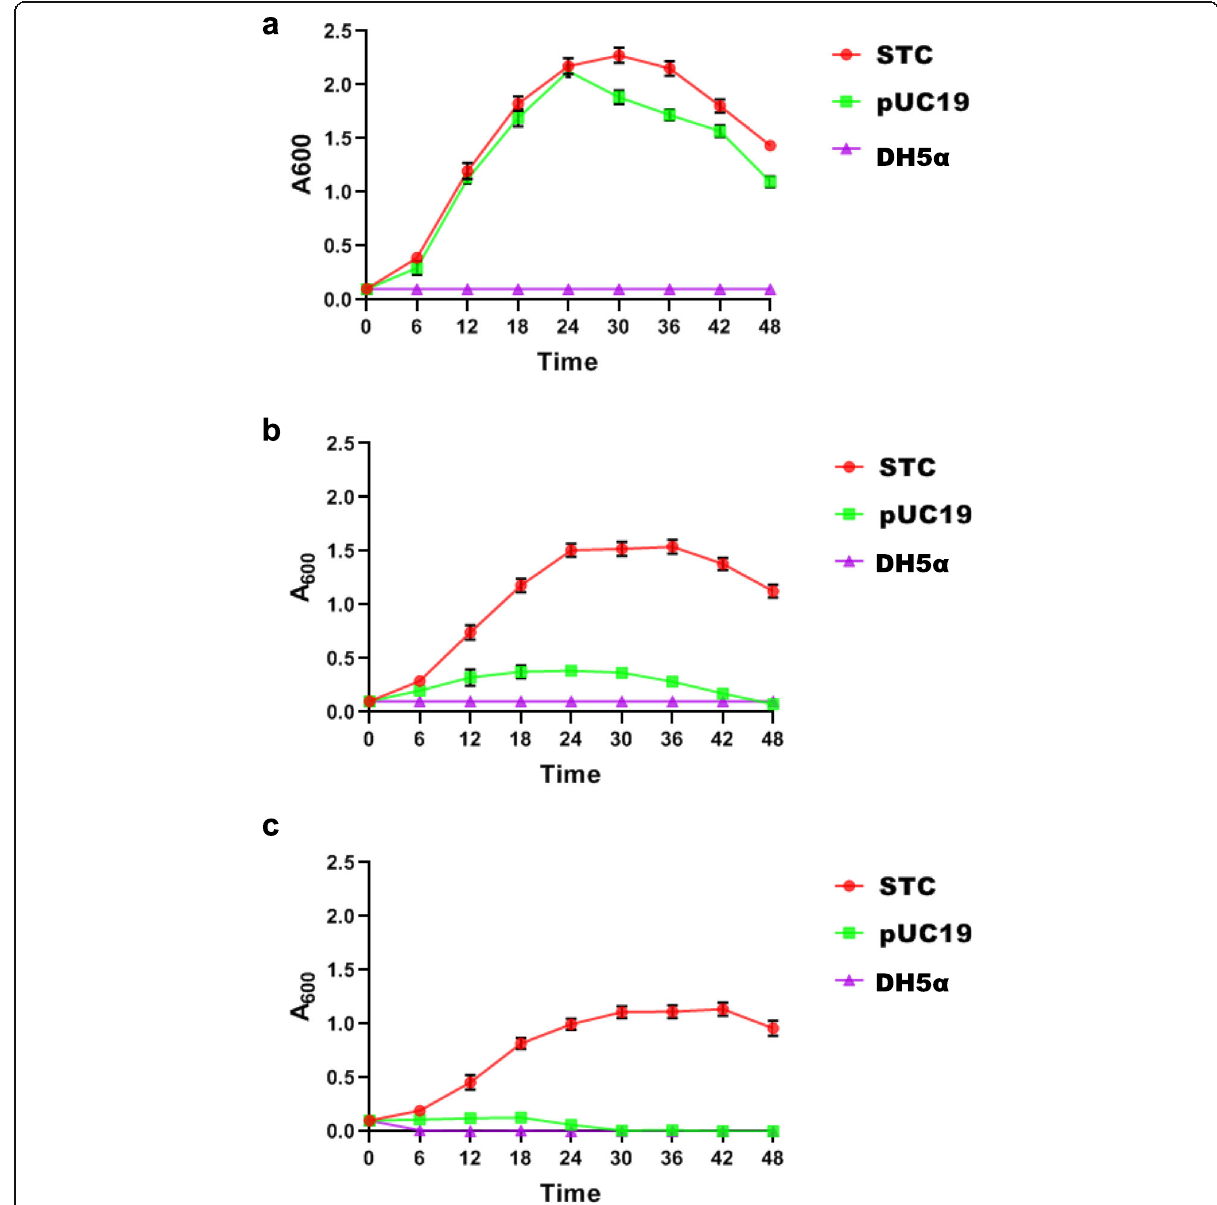
Fig. 2 Growth kinetics of recombinant clone STC. Panel a represents control with ampicillin and without added salt; panels b and c represent salinity treatment with 0.75 M NaCl and 1 M NaCl, respectively, in the presence of ampicillin. Recombinant clone STC (red line) in DH5 α , DH5 α containing pUC19 (green line), and DH5 α host strain (violet line) were inoculated in the LB medium supplemented with ampicillin ( a ), LB medium supplemented with ampicillin and 0.75 M NaCl ( b ), and LB medium supplemented with ampicillin and 1 M NaCl ( c ). Cells were withdrawn at different intervals, and absorbance was measured at 600 nm. Data of three independent experiments was plotted with standard